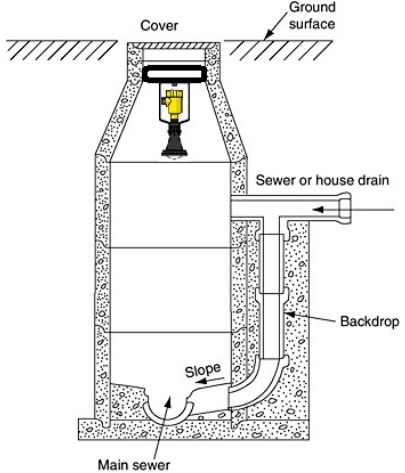
Figure 4. A typical manhole with radar sensor.